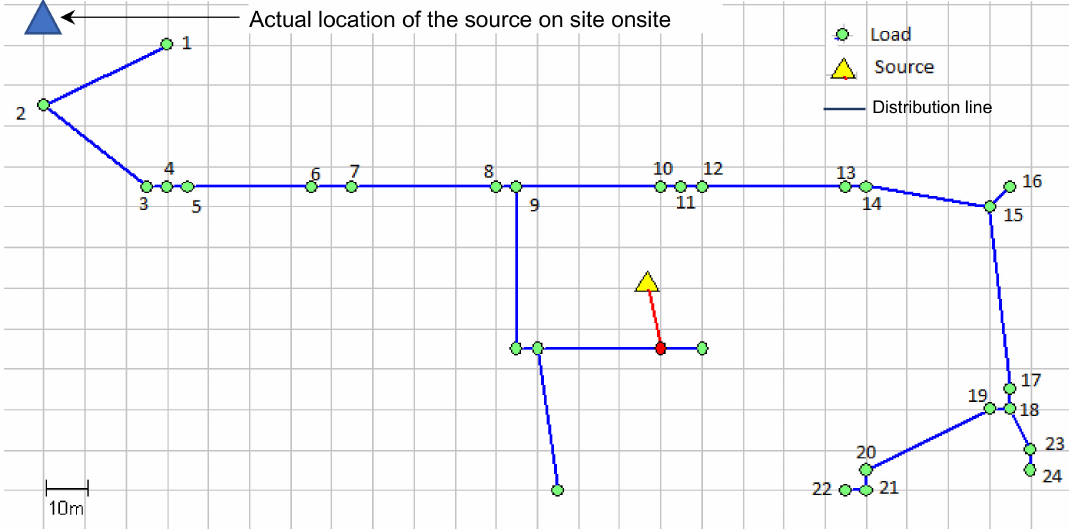
Figure 19. Network structure obtained for the Rajmachi system using simulated annealing. Also indicated is the actual location of PV source